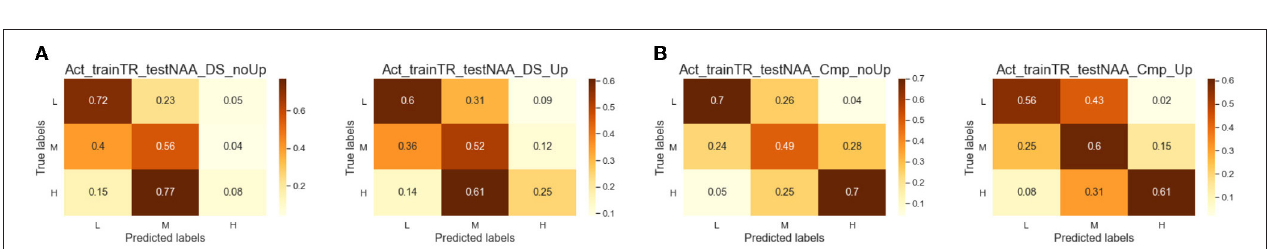
FIGURE 5 | Confusion matrices (in percentage) for training on TR and testing on the non-actor part of NAA. (A) Experiments using the DEEPSPECTRUM features with no upsampling (left) and upsampling (right). Note a slight increase in recall of the high class for upsampling. (B) Experiments using the COMPARE features with no upsampling (left) and upsampling (right). Note a slight decrease in recall of the high class for upsampling.